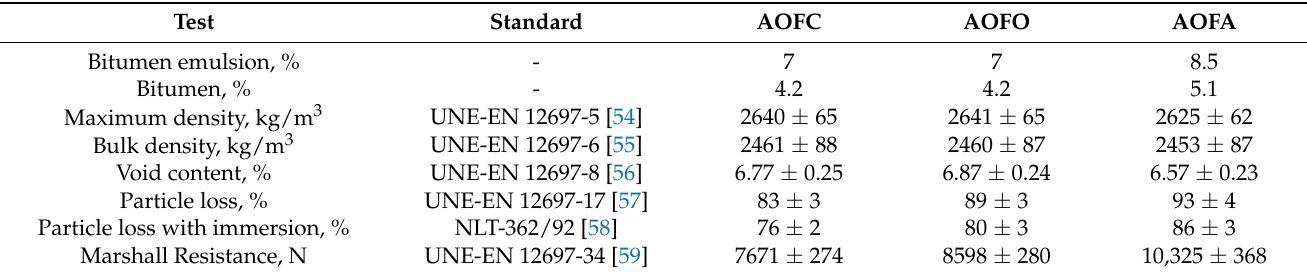
Table 9. Optimum percentage of emulsion and residual bitumen for AOFC, AOFO, and AOFA bituminous mixes. Table 10. Physical and mechanical tests of the different families of specimens made with the three fillers, AOFC, AOFO, and